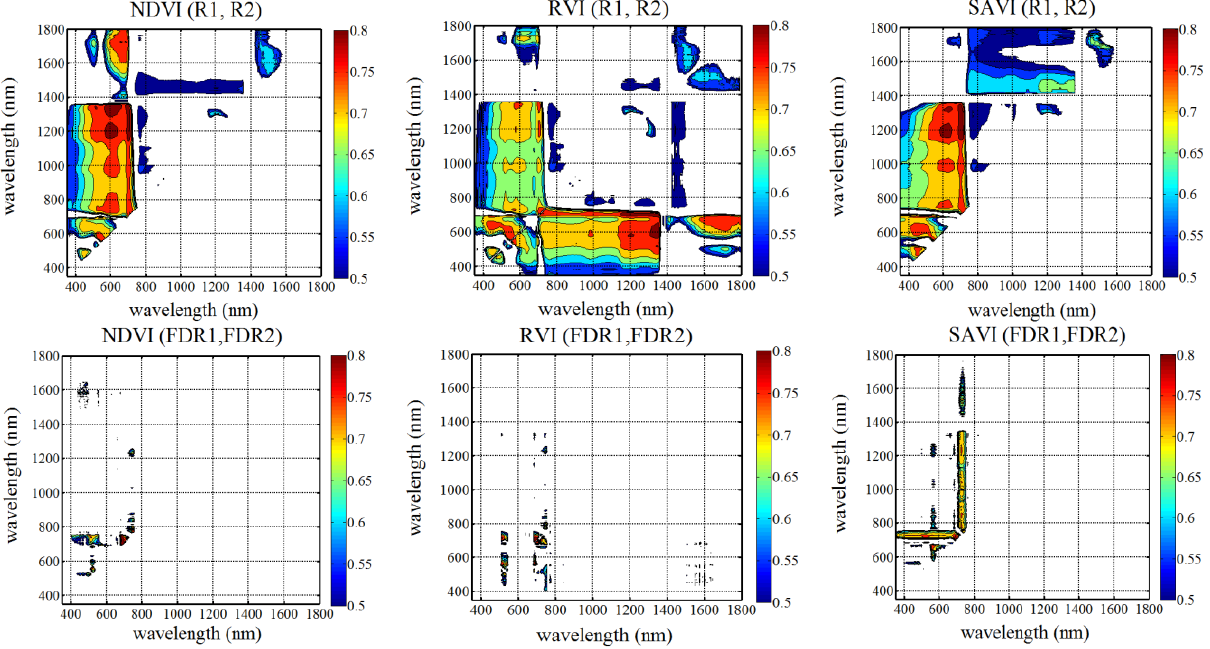
Figure 4. Contour maps of the coefficients of determination (R 2 > 0.5) between the normalized difference vegetation index (NDVI), ratio vegetation index (RVI), and soil-adjusted vegetation index (SAVI) and the canopy LNC based on the original and first derivative canopy